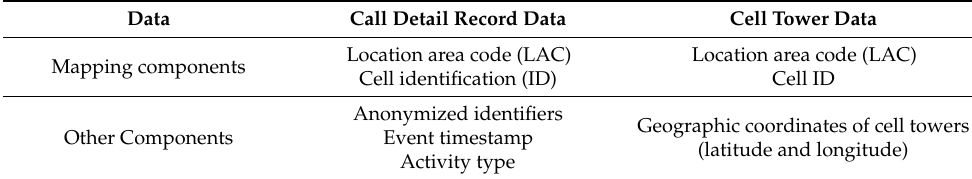
Table 3. The data components of the CDR data and cell tower data.